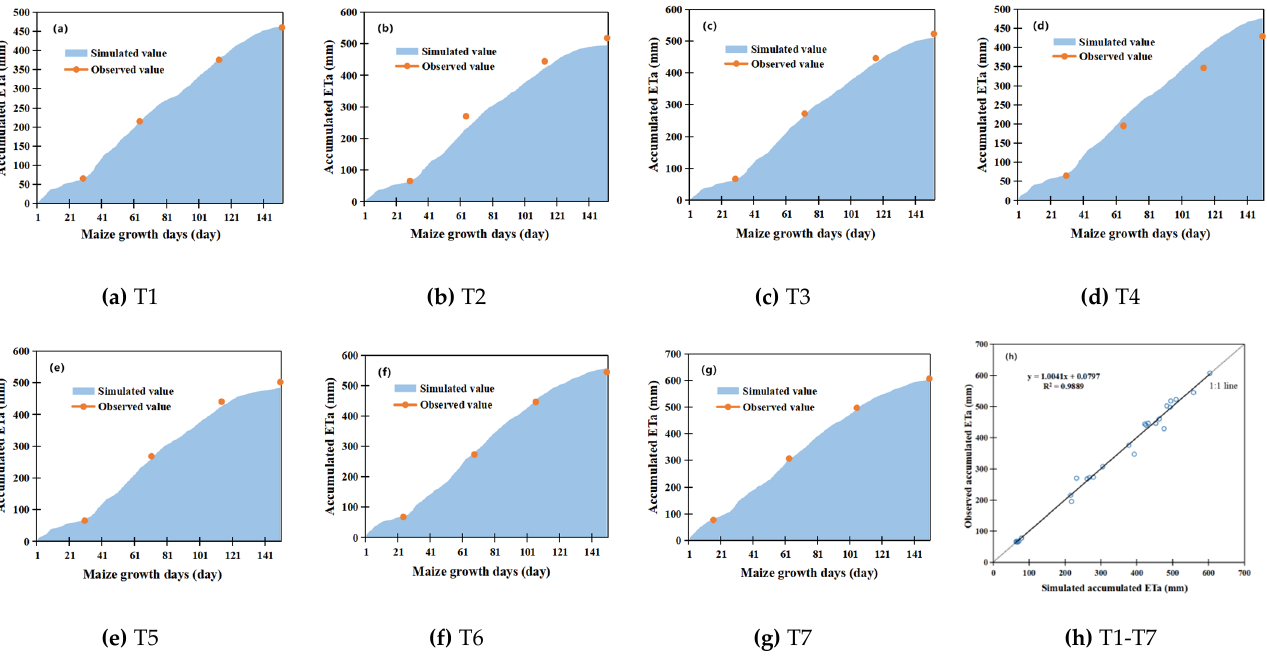
Figure 4. Observational and simulated cumulative ET a during the whole growth period of maize, ( a ) T1, ( b ) T2, ( c ) T3, ( d ) T4, ( e ) T5, ( f ) T6, ( g ) T7 and ( h ) calibration of ET a for different stages (2014–2015).